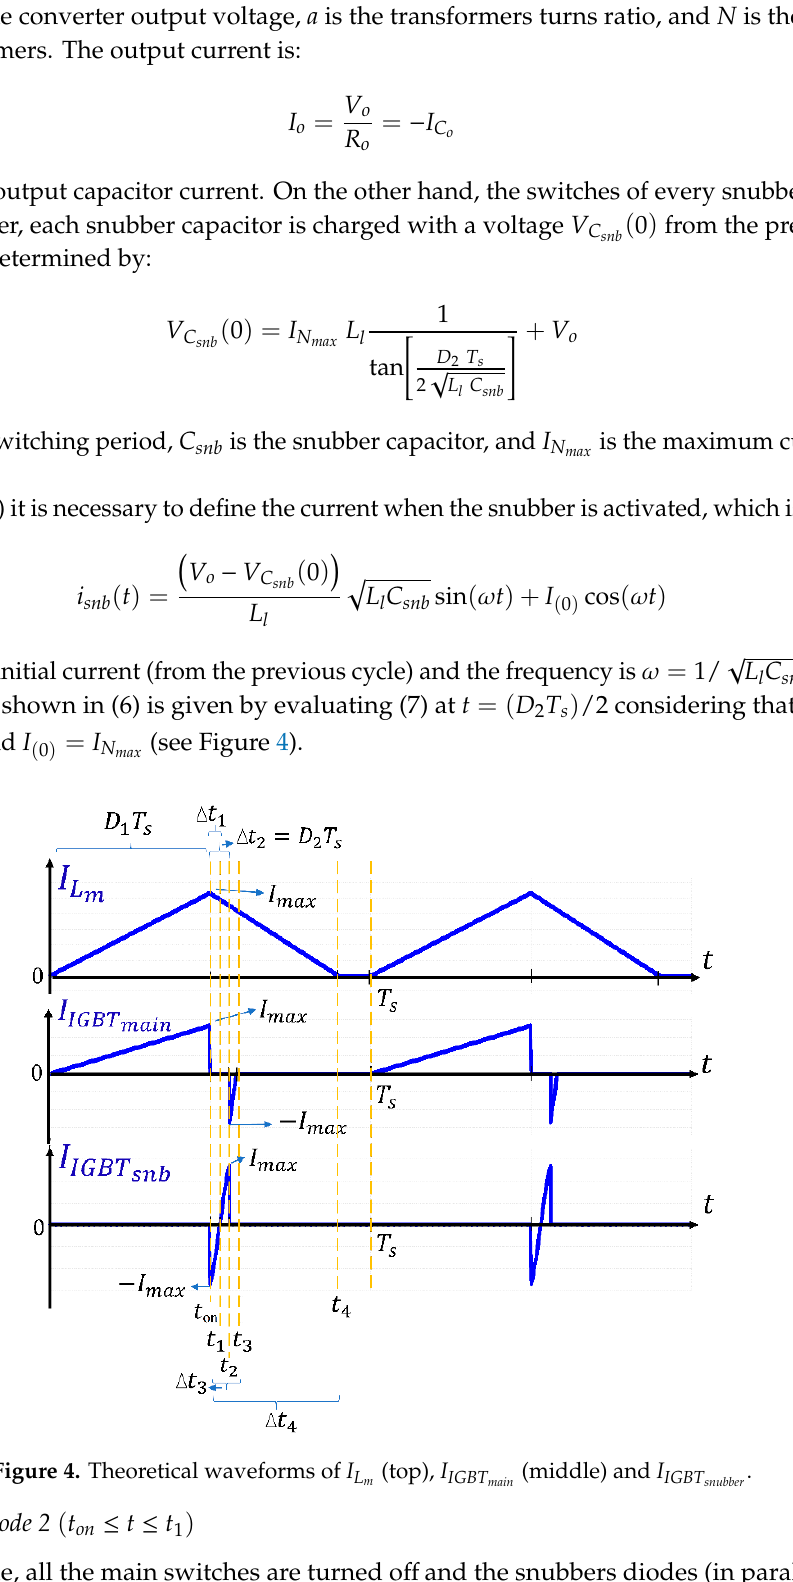
Figure 4. Theoretical waveforms of 𝐼 (cid:3013)